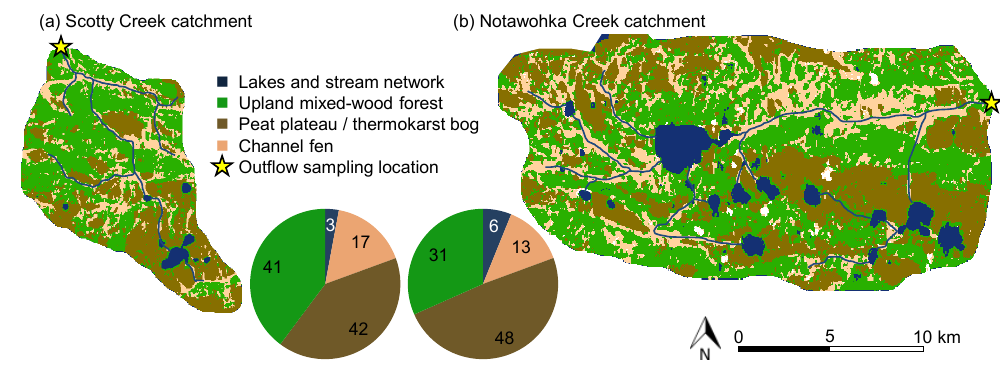
Figure 2. Land cover distribution and stream networks within (a) Scotty Creek and (b) Notawohka Creek catchments. Land cover classifi- cation was done through supervised classification using maximum likelihood methodology. Pie charts indicate the percent coverage of each land cover type within each catchment.